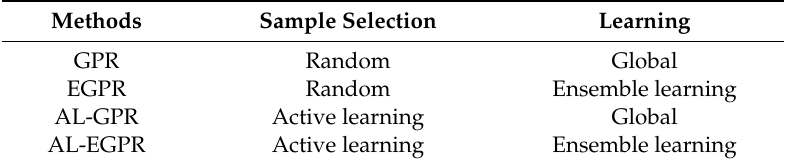
Table 2. Characteristics of di ff erent soft sensor modelling